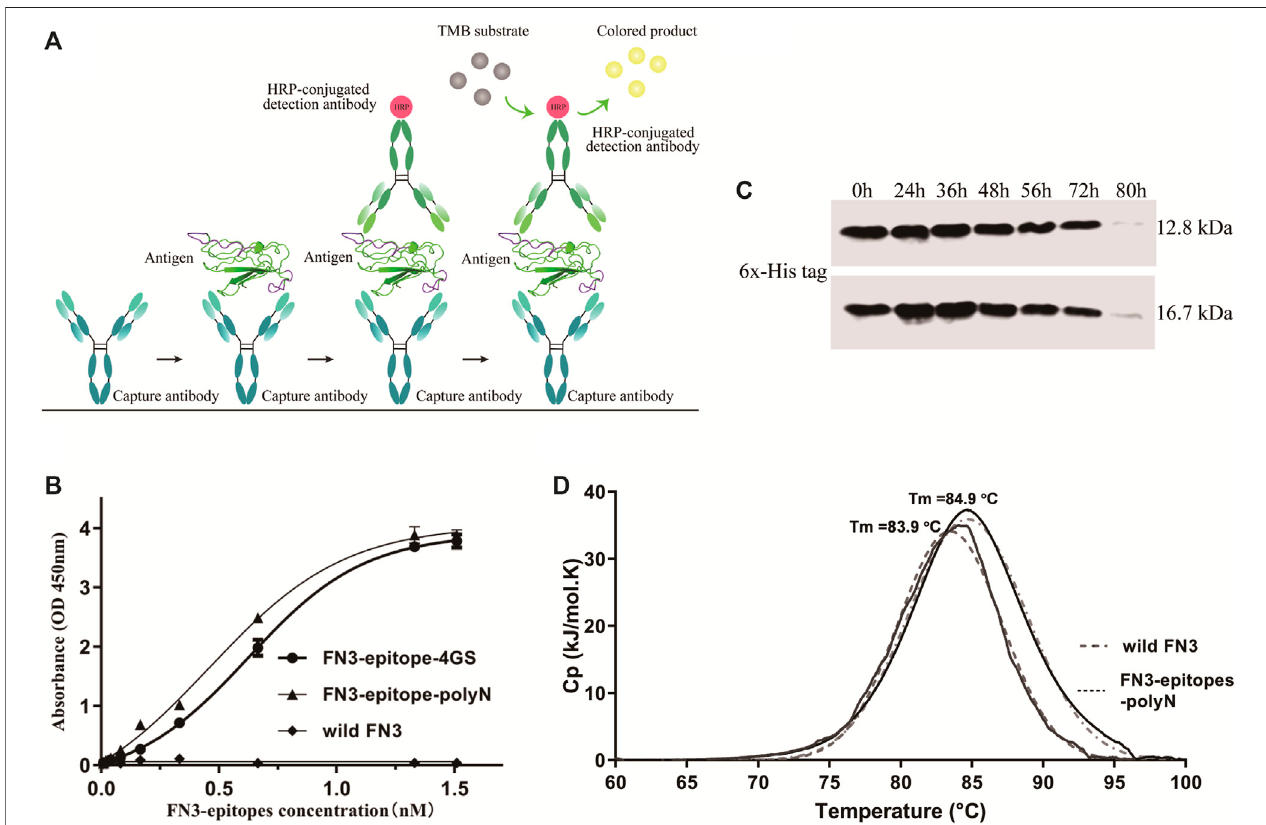
FIGURE 4 | The immunoreactivity and stability detection of the recombinant FN3-epitopes-polyN. ( A ) The scheme of sandwich ELISA. ( B ) The immunoreactivity detected by sandwich ELISA. Capture antibody: mouse anti-human NT-proBNP 4NT1-15C4 (3.5 μ g/ml), Detection antibody: HRP-conjugated mouse anti-human